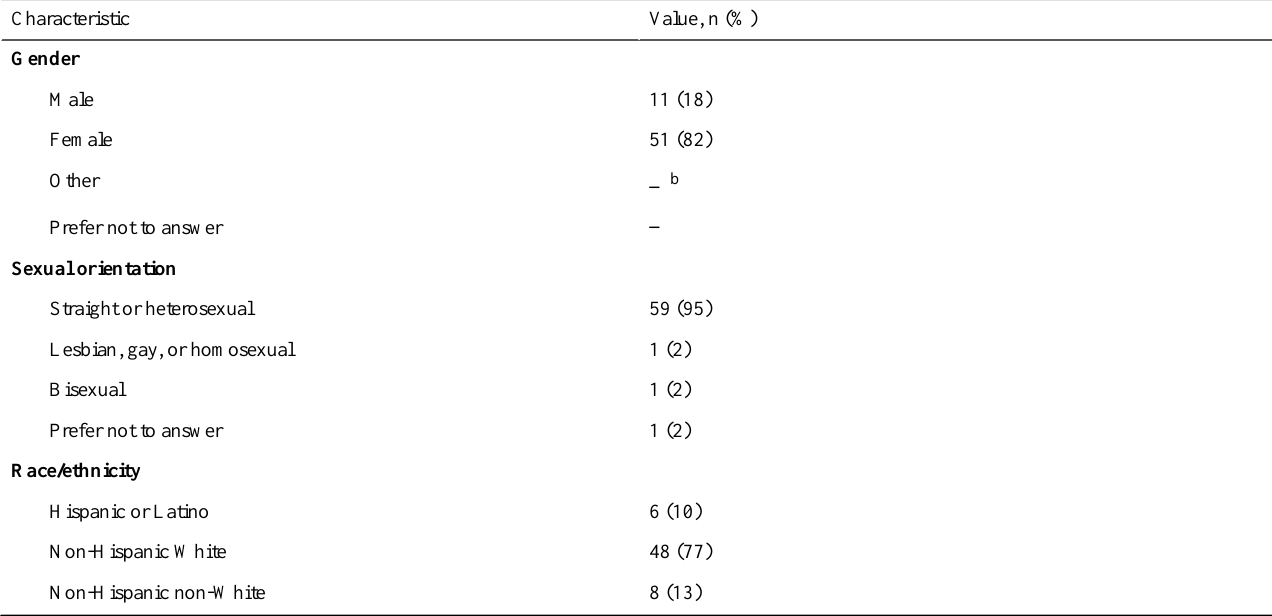
Table 2. Demographic characteristics of participants in the Be Present online training intervention pilot test for youth suicide prevention at baseline, May-June 2019 (n=62) a